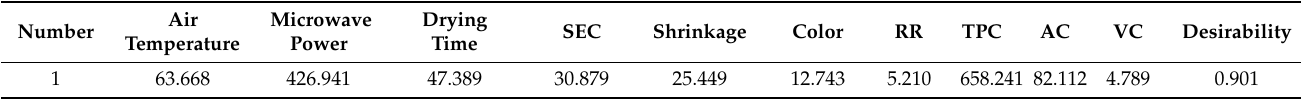
Table 14. Results of optimization by desirable function of RSM .